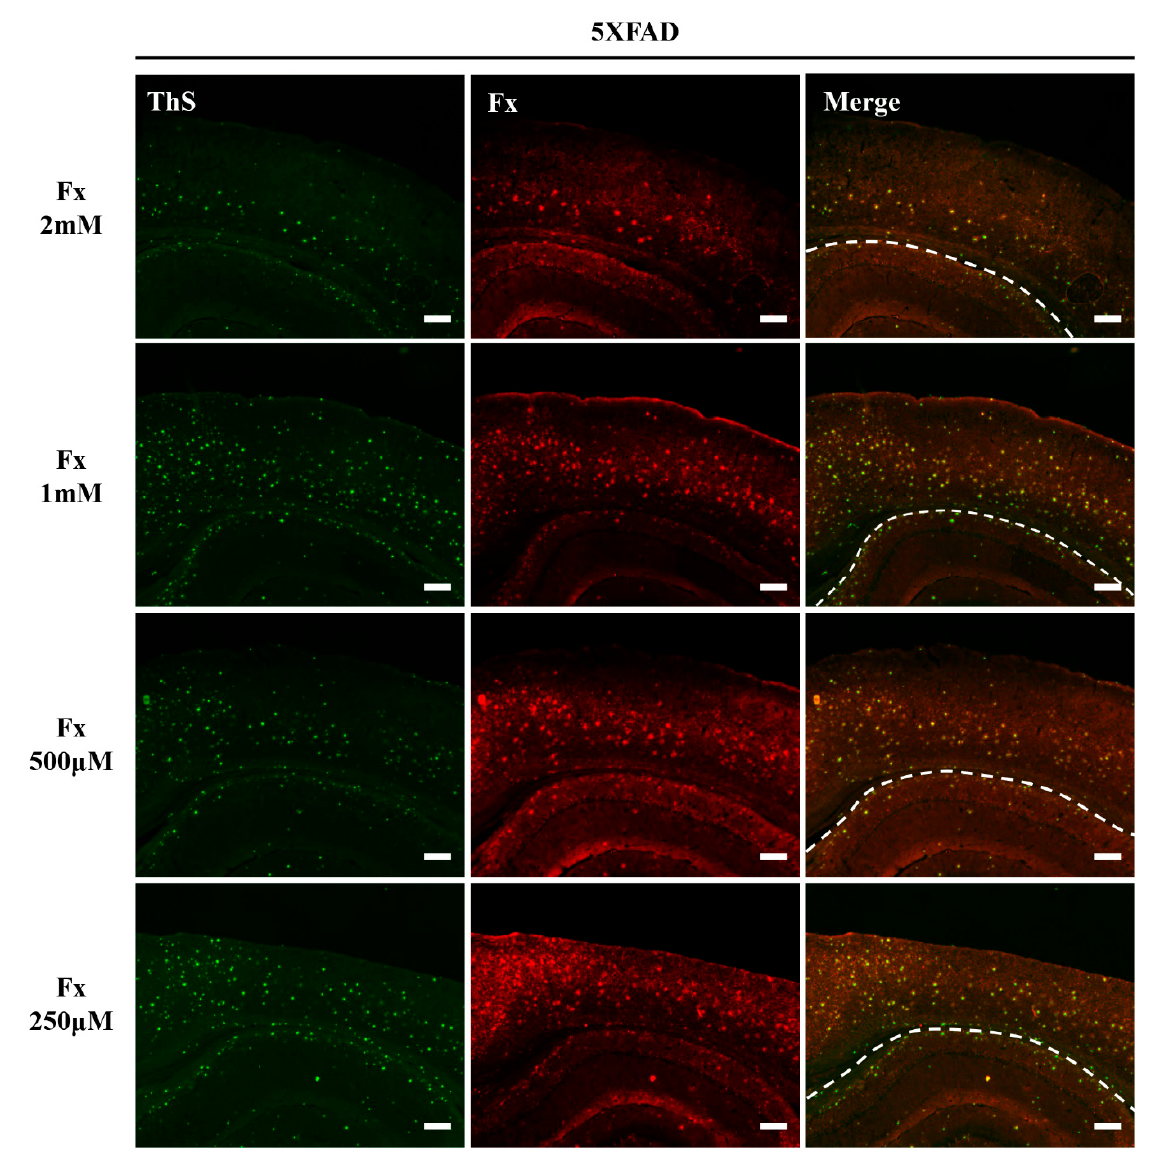
Figure 6. Fucoxanthin staining using organic solvent-based washing method detected ThS-positive A β plaques in 5×FAD brain tissue. The brains of 10–15-month-old 5×FAD mice ( n = 4) were visualized for A β plaques with fucoxanthin (Fx) and ThS. The images of ThS and Fx are merged to confirm that they are colocalized. Scale bars = 200 μ m. The region of brain was separated with the white dash line on the images; upper region of dash line, cortex; under region of dash line, hippo- campus.